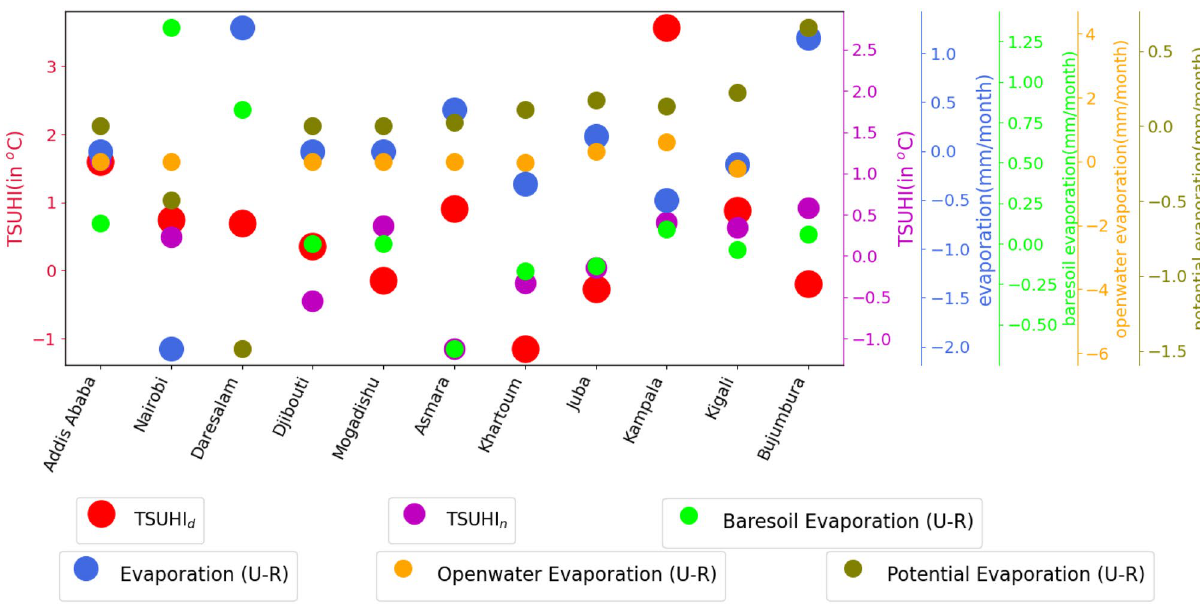
Figure 9. Urban evaporation affecting the tropical surface urban heat islands (TSUHIs) in the Greater Horn of Africa (GHA) region. Different sizes and colors of circular objects are used to represent the different variables. The large circles with the red and pink colors represent tropical surface urban heat islands during the day and night respectively, the blue, orange, light green and dark green colors represent the total, open water, bare soil, and potential evaporation differences between urban and rural areas respectively. The y-axis line colors and labels have similar colors with the circles representing each of the variables. The y-axis for TSUHI n , total, bare soil, open water and potential evaporation are shown on the right side. The x-axis shows the corresponding capital cities in the east Africa